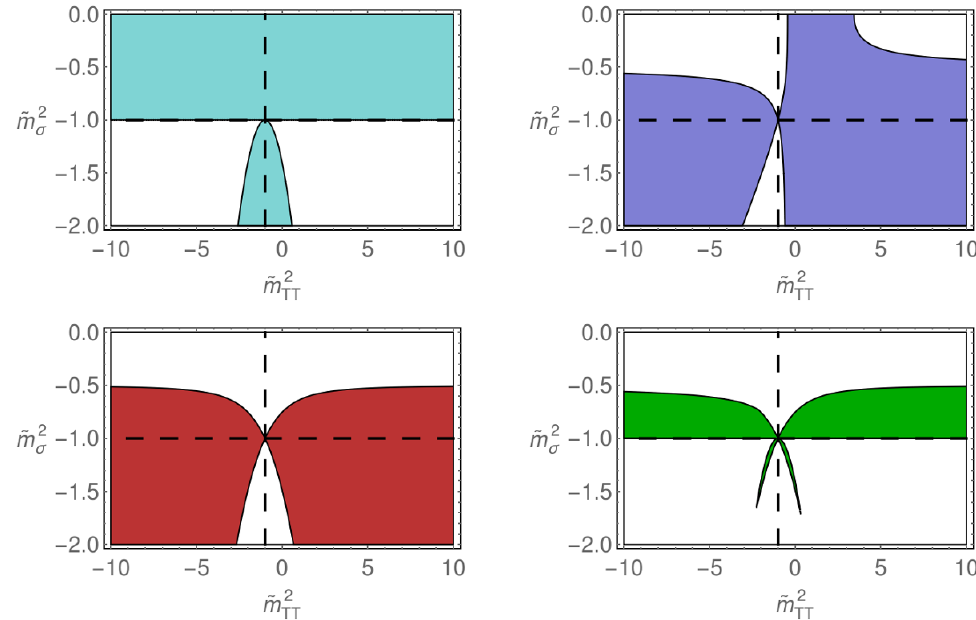
Figure 13 . Region plots for the sign of the gravitation contribution to SM-like couplings in terms of the symmetry breaking masses ~ m 2 and ~ m 2 (with vanishing curvature squared couplings). From (cid:27) TT left to right and top to down: i) (cid:17) (cid:30) j grav > 0 (cyan region); ii) (cid:0) f g = (cid:17) A j grav < 0 (blue region); iii) (cid:0) (cid:1) (cid:0) f y = (cid:17) + 1 (cid:17) (cid:30) + D y < 0 (dark red region); iv) combined plot (dark green) with (cid:17) (cid:30) j grav > 0, 2 grav (cid:0) f g < 0 and (cid:0) f y <